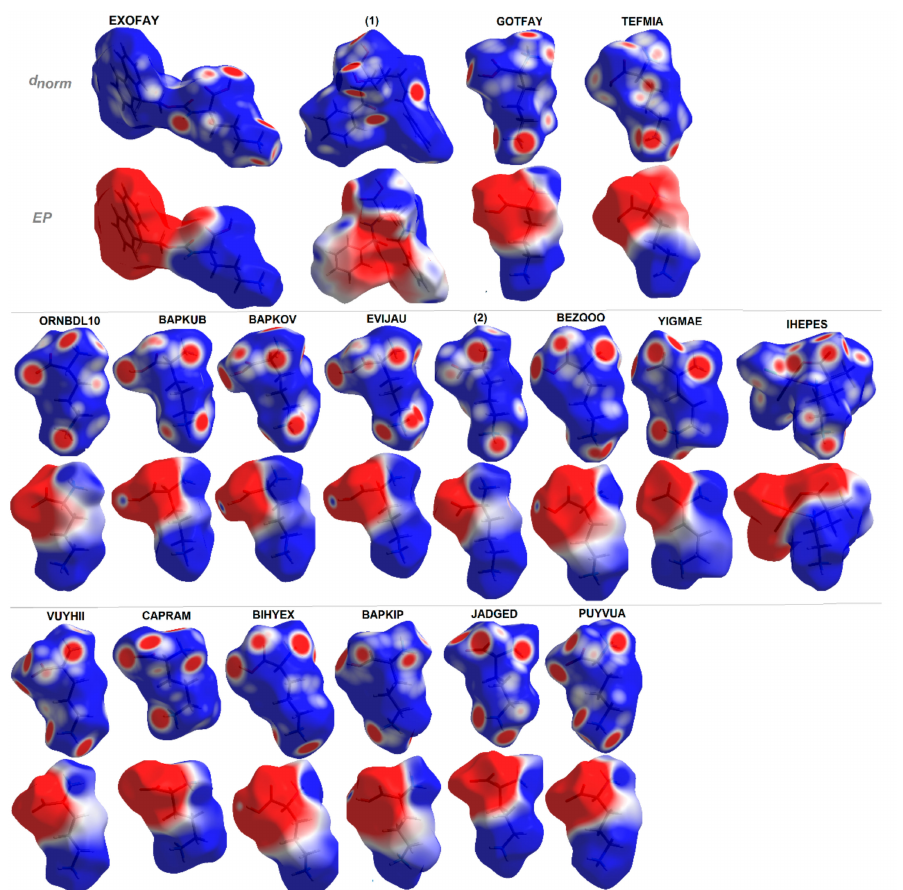
Figure 10. Molecular electrostatic potentials (EPs) of ornithine-based crystals plotted on Hirshfeld surfaces. For interpretation of the references to color in this figure legend, the reader is referred to the web version of this